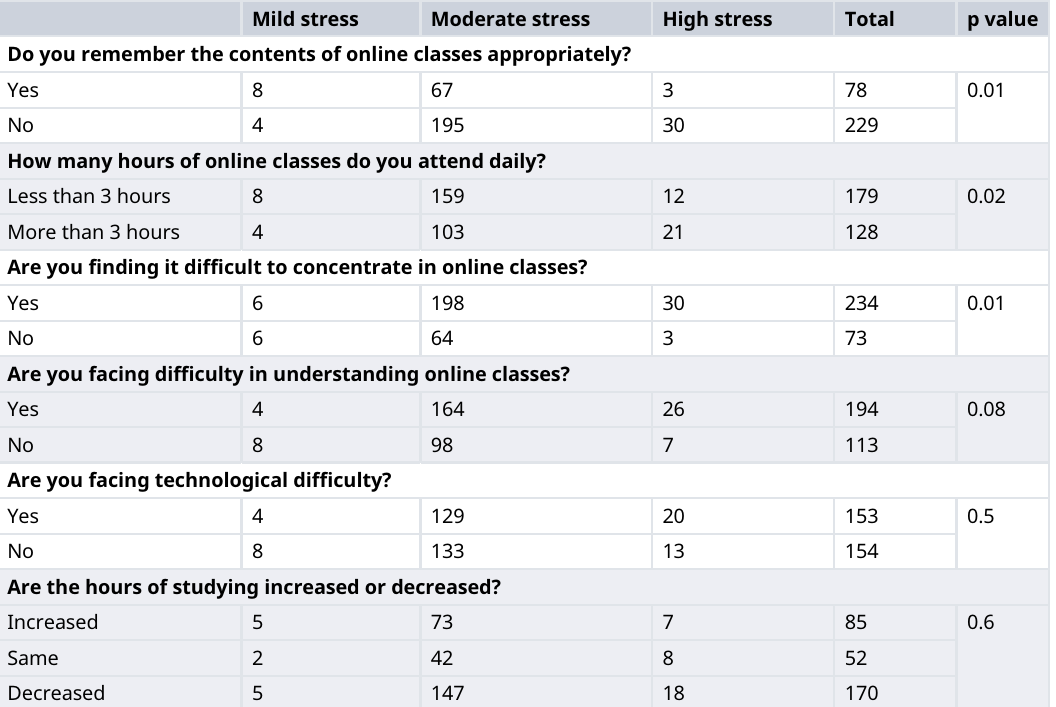
Table 3. Association of perceived stress categories with involvement in online classes (n =